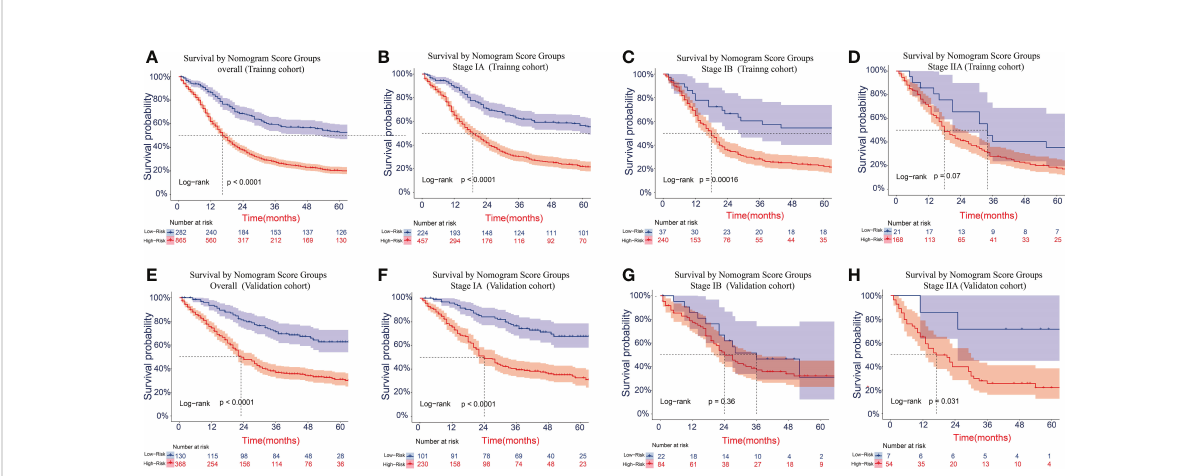
FIGURE 9 Kaplan – Meier survival curves for LCSS in the overall and stage-strati fi ed patients in the training (A – D) and validation (E – H) cohorts to test the risk strati fi cation system based on the training cohort. The red line represents the high-risk group, and the blue line represents the low-risk group. LCSS, lung cancer-speci fi c